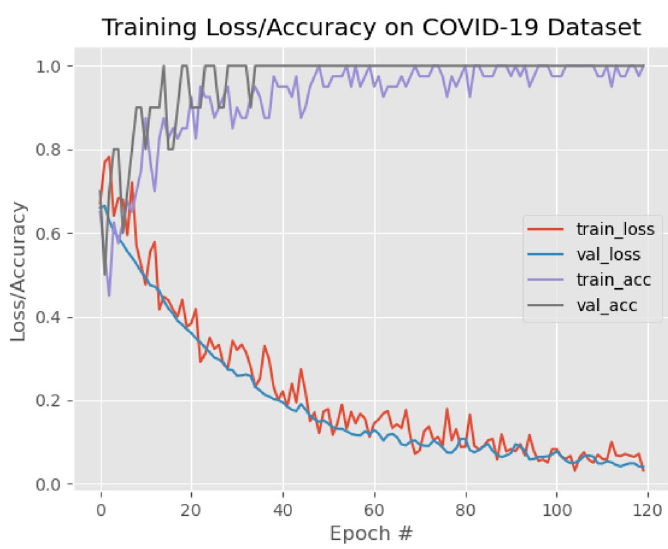
Figure 6. Loss/accuracy graph.